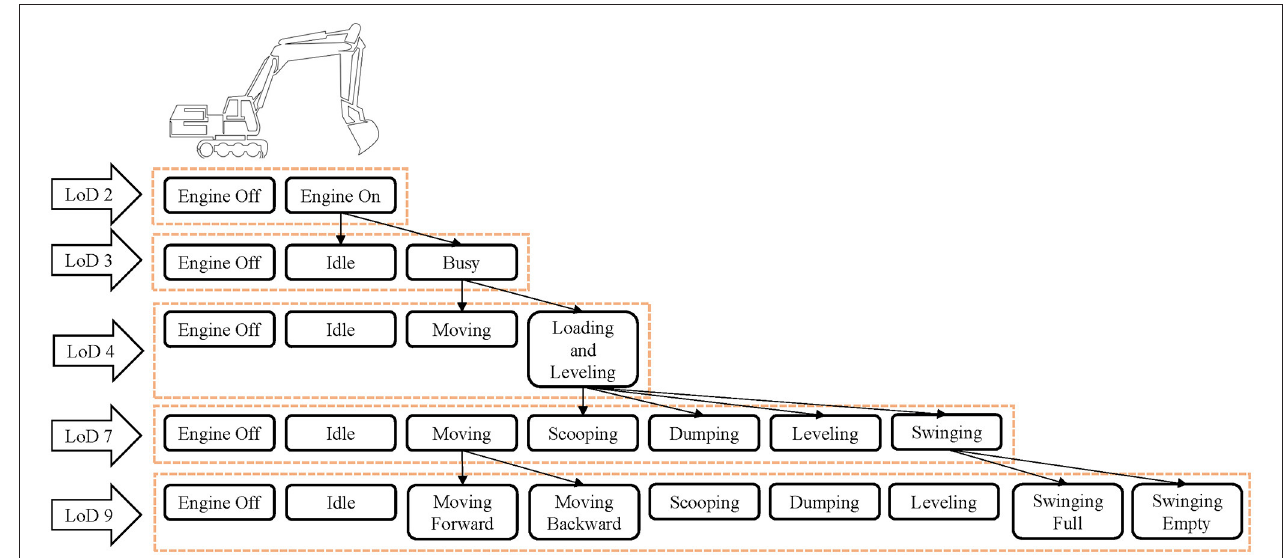
FIGURE 6 | LoD in activity breakdown of an excavator.